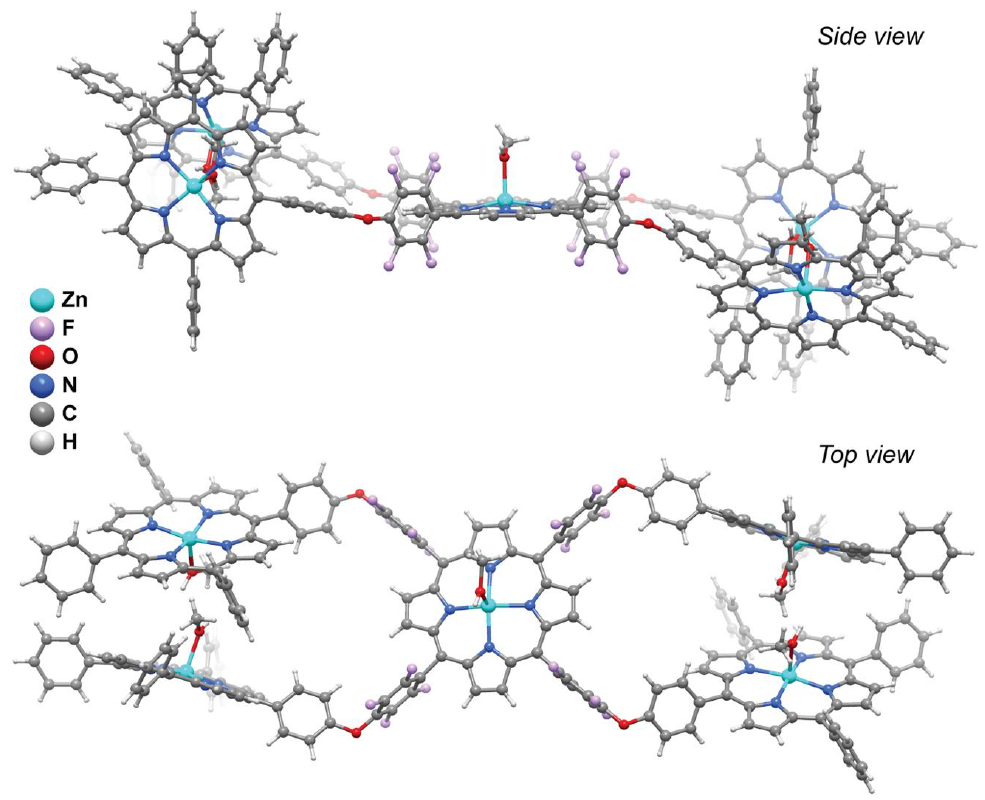
Figure 3. Schematic representation of the pentaporphyrin molecular unit present in the crystal structure of Zn 5 · Solvent.